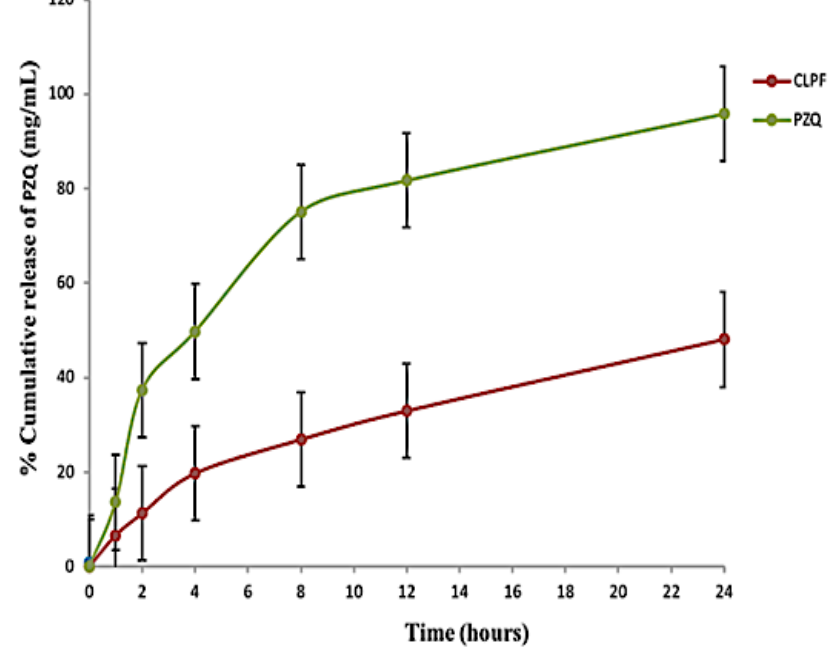
Figure 7. In vitro release profile of native PZQ, PZQ-loaded SLNs (CLPF). Temperature = 37 ± 1 °C, Release medium = PBS, pH = 7.4 (containing 0.002% Tween 80) ( n = 3, mean ± SD).